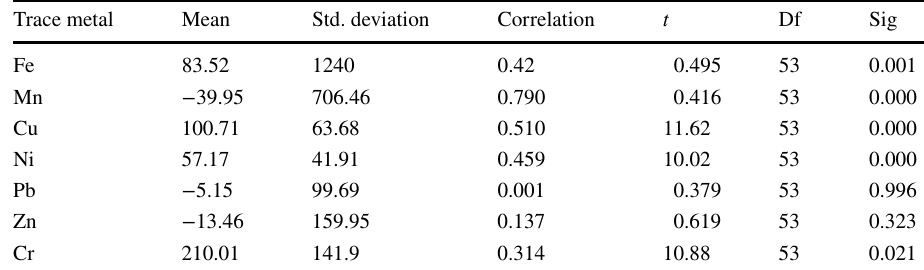
Table 2 Results of paired sample t -test of the heavy metals in pre-monsoon and post-monsoon